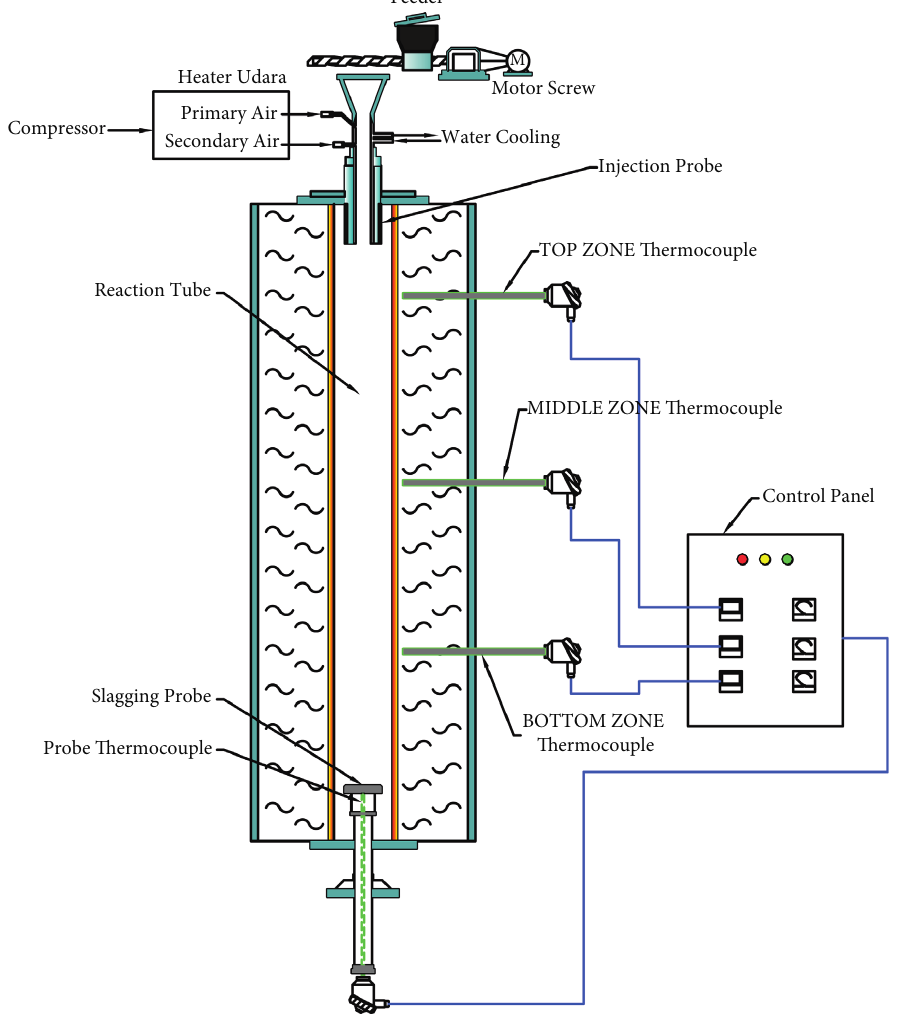
Figure 1: The schematic drawing of the drop tube furnace